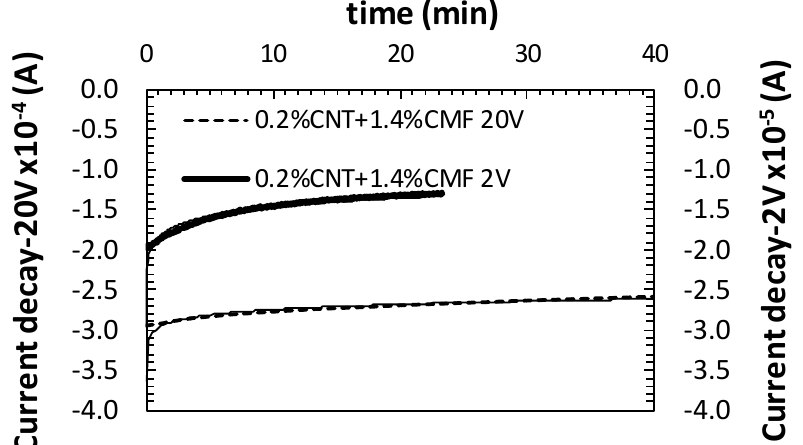
Figure 3. Current decay and stabilization after 2 and 20 V polarization.